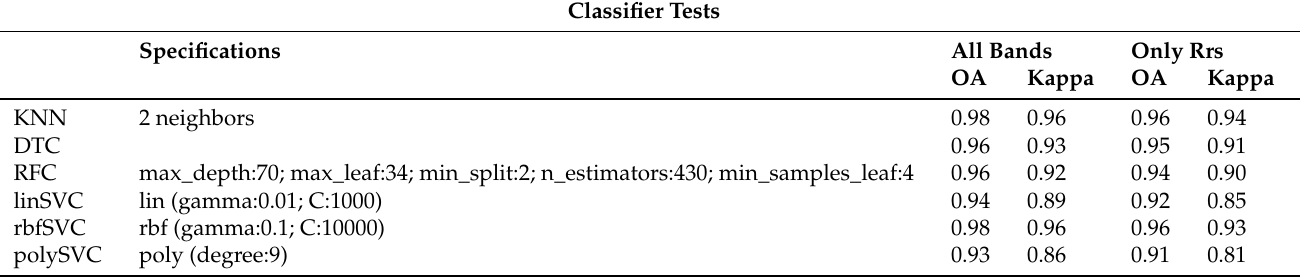
Table 1. Statistics of the tested models. KNN refers to K-nearest neighbor; DTC, decision tree classifiers; RFC, random forest classifiers; linSVC is the linear support vector classifier; rfbSVC is the non-linear radial basis function (RBF) kernel for the SVC; and polySVC, the polynomial kernel for the SVC.